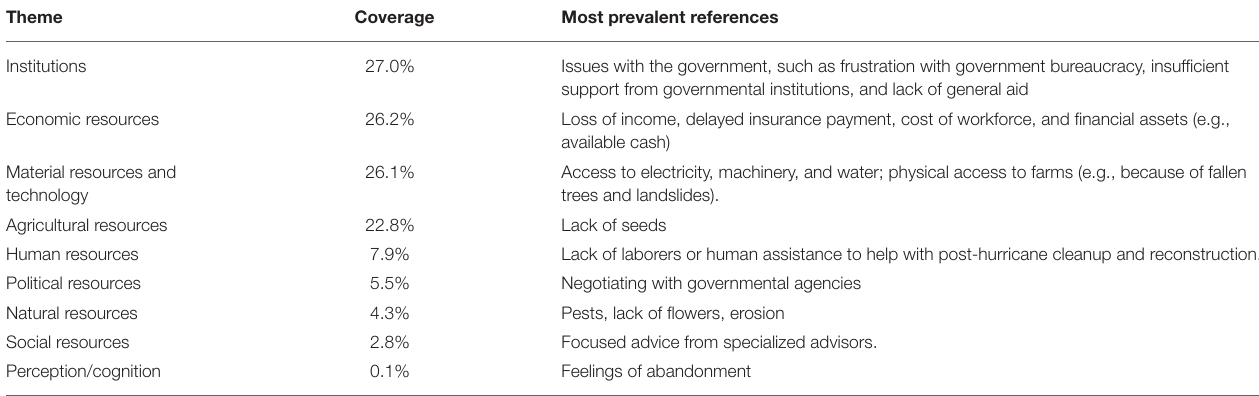
TABLE 5 | Coding coverage—the percentage of content coded-for each set of adaptive capacity